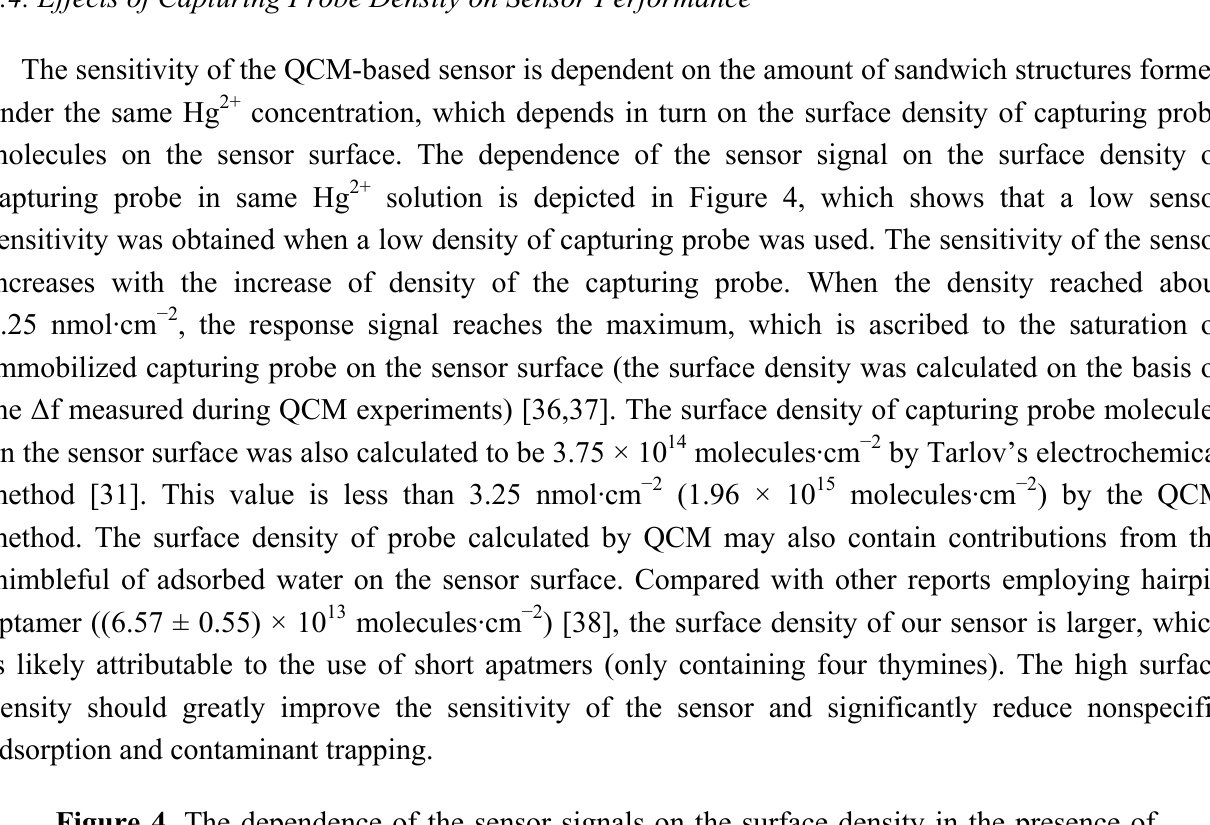
Figure 4. The dependence of the sensor signals on the surface density in the presence of 50 nM Hg 2+